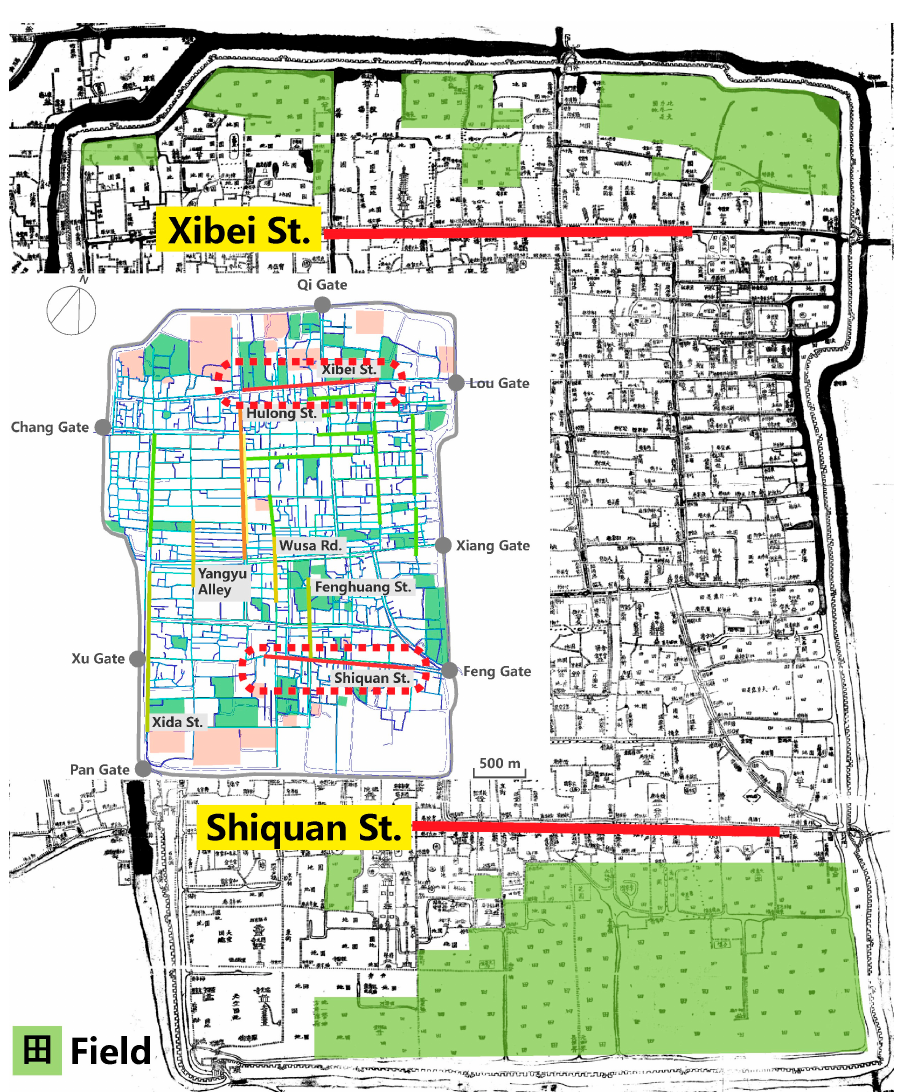
Figure 4. Fields on the north side of Xibei Street and the south side of Shiquan Street in the Map of Suzhou City